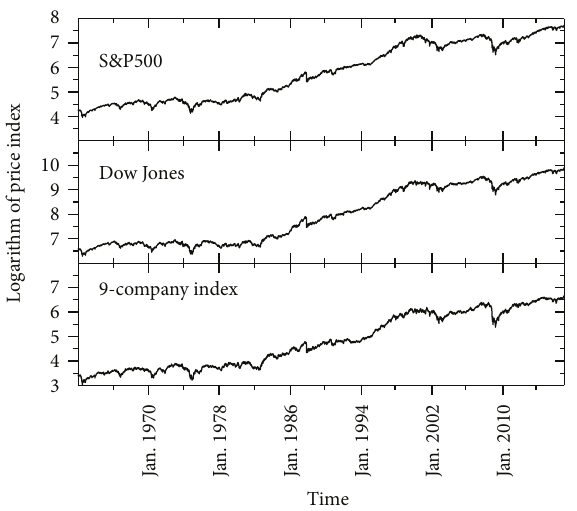
Figure 8: Daily prices of the S&P500, of the Dow Jones, and of the sum of 9 DJIA stocks listed on the NYSE over the period from January 1, 1962, to July 07, 2017 (13,812 points). The companies included are GE (General Electric), AA (Alcoa), IBM (International Business Machines), KO (Coca-Cola), BA (Boeing), CAT (Caterpillar), DIS (Walt Disney), HPQ (Hewlett-Packard), and DD